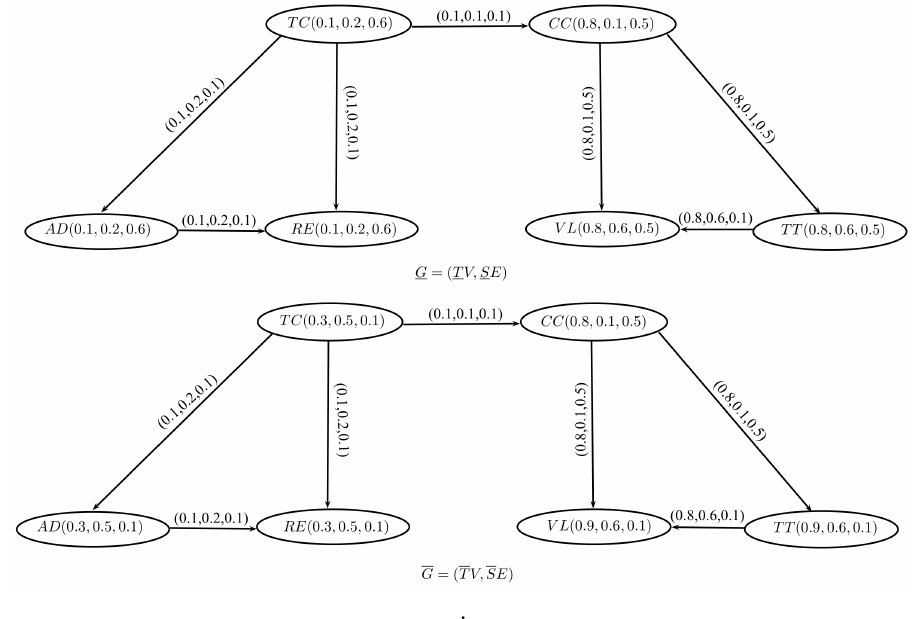
Figure 14. Rough neutrosophic digraph G = ( G , G )